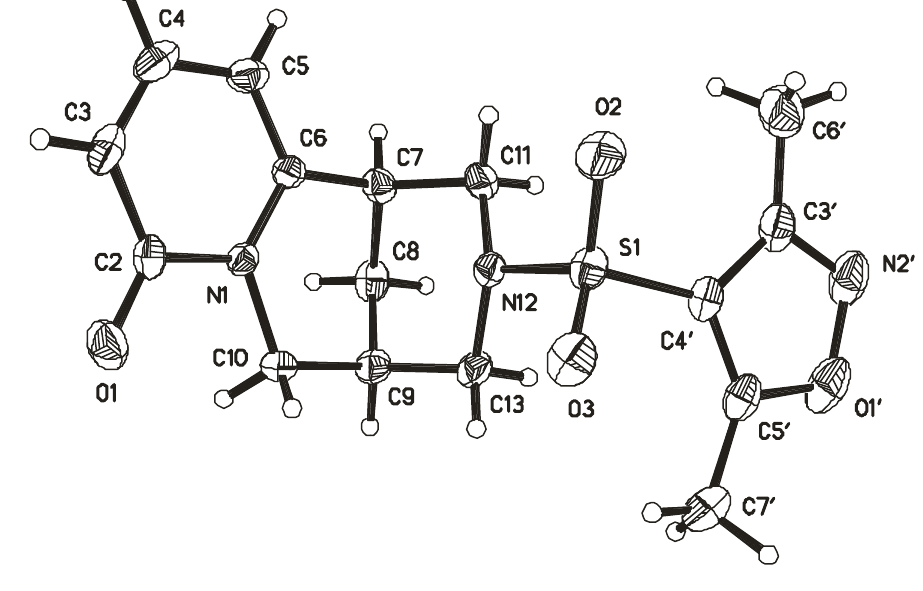
Figure 2. A general view of molecule 2.